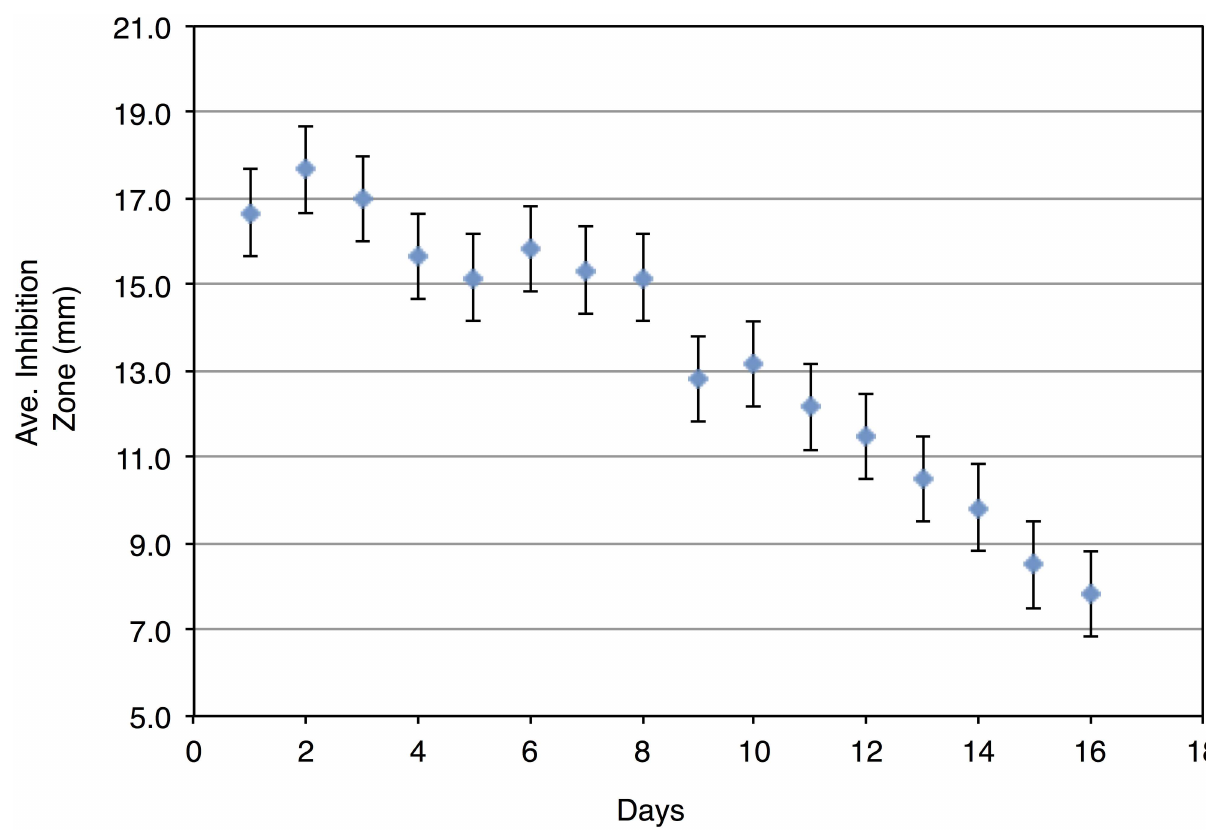
Fig 5. Antibacterial activity of the extract loaded Tabasheer-derived pSi carrier against S . aureus . Using a disk diffusion assay, the release of antibacterials and associated activity was monitored until the activity